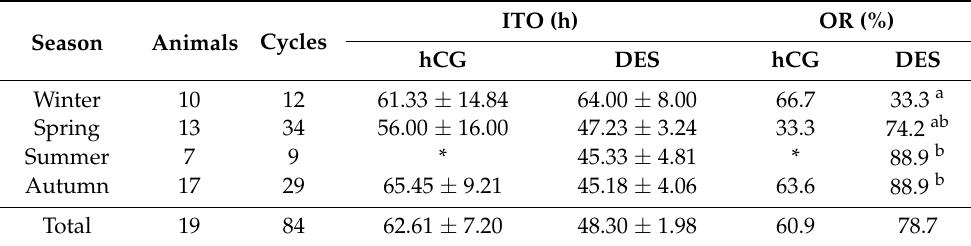
Table 7. Effect of season on the interval to ovulation (ITO) and ovulation rate (OR) in cycles of jennies treated with human chorionic gonadotropin (hCG) and deslorelin acetate (DES). ITO (h) OR (%) Season Animals Cycles hCG DES hCG DES Winter 10 12 61.33 ± 14.84 64.00 ± 8.00 Spring 13 34 56.00 ± 16.00 Summer Autumn 17 Total 19 84 48.30 ± 1.98 78.7 a,b Different superscripts indicate significant differences ( p < 0.05). * Missing data.